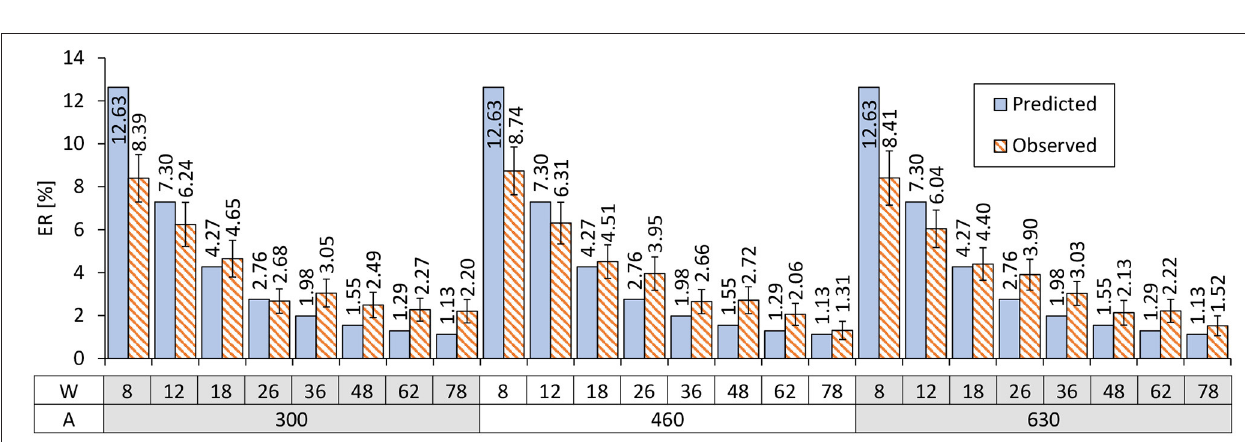
FIGURE 8 | Comparison of the predicted vs. observed ER s. Error bars indicate 95% confidence